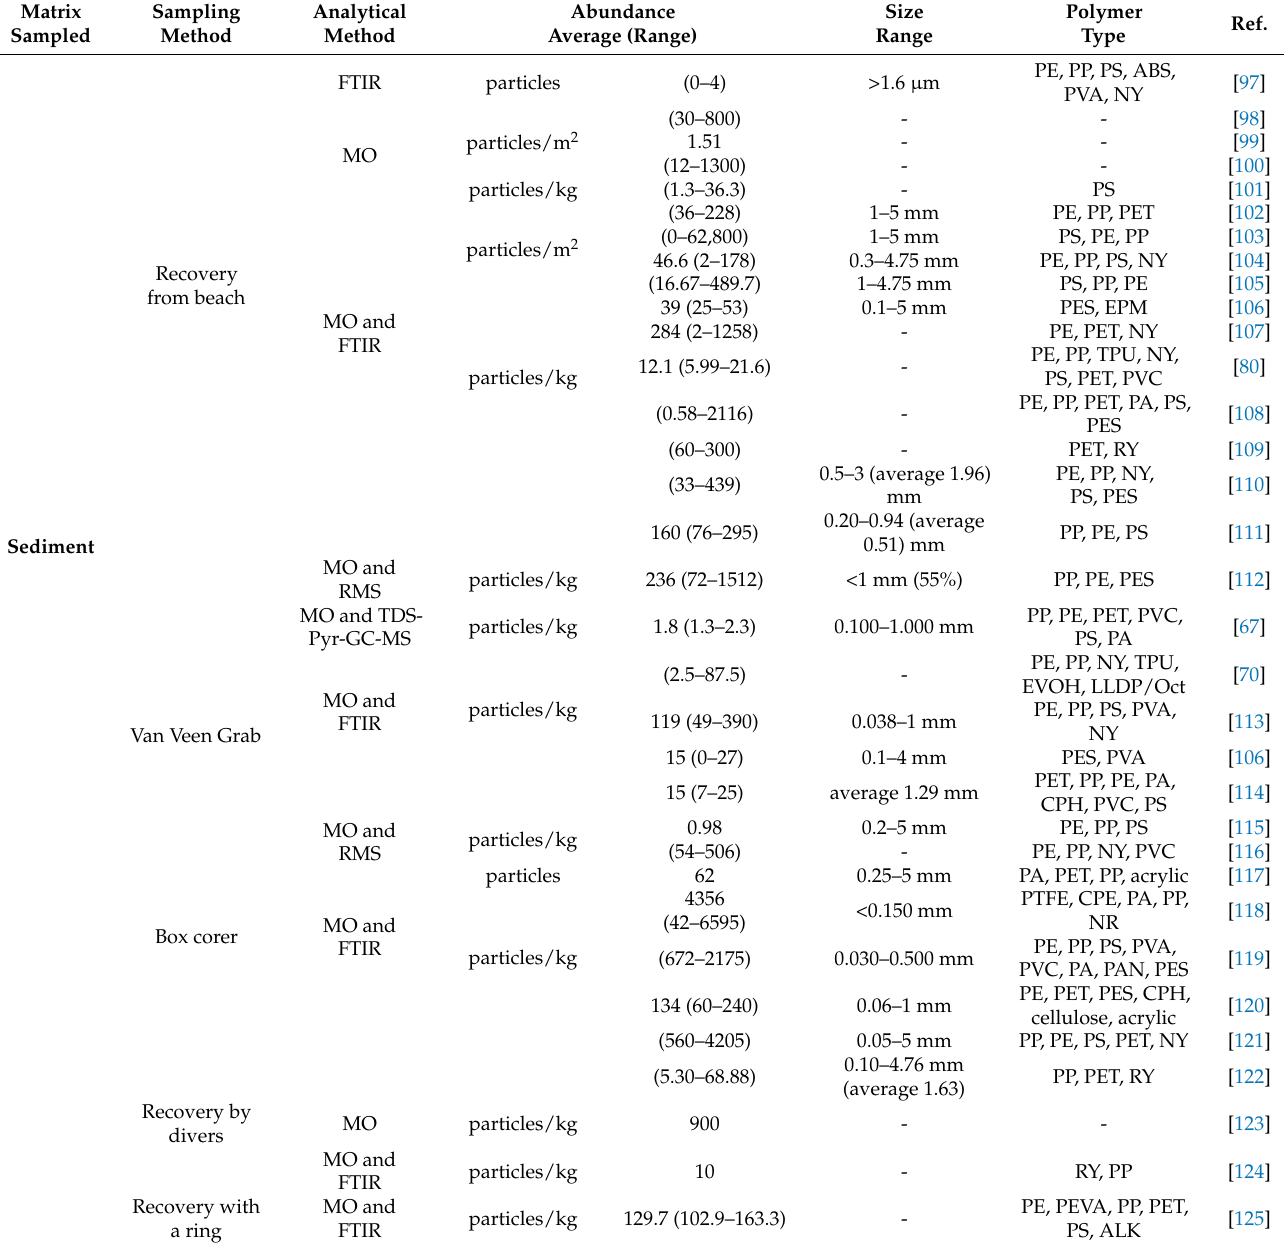
Table 1. Microplastics abundance in the marine